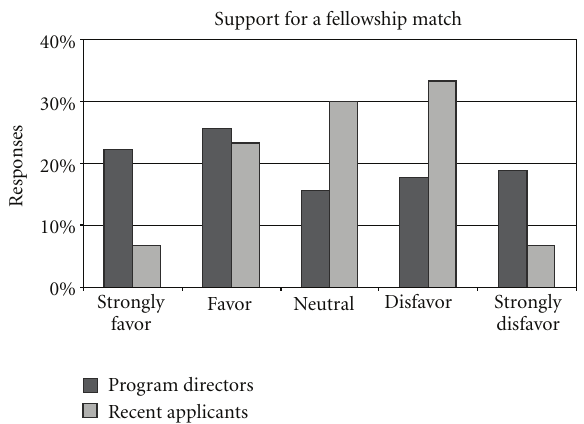
Figure 5: Column chart comparing support for a fellowship match between program directors and recent